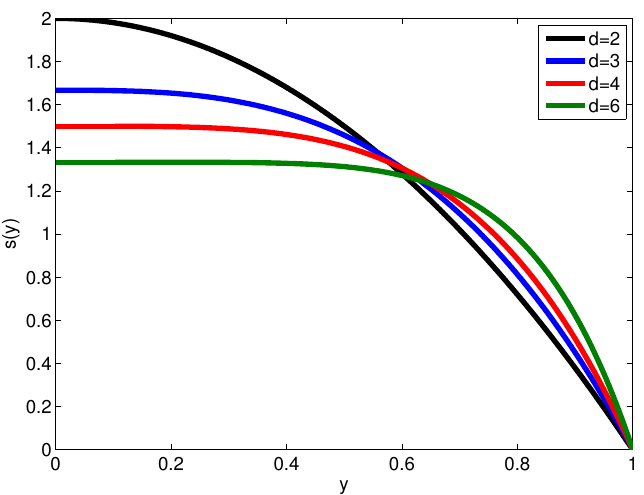
Figure 1. Plots of s ( y ) at different values of d